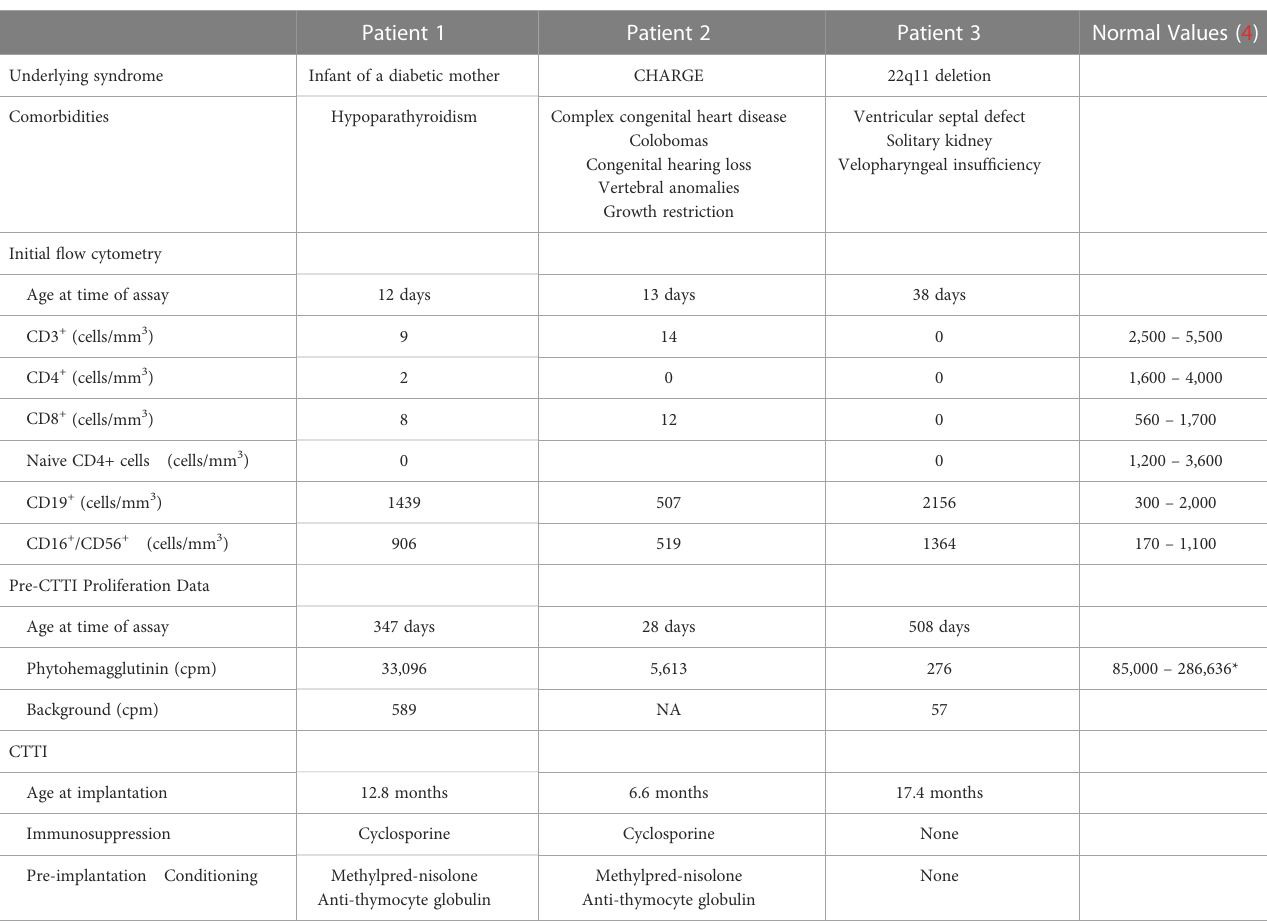
TABLE 1 Patient